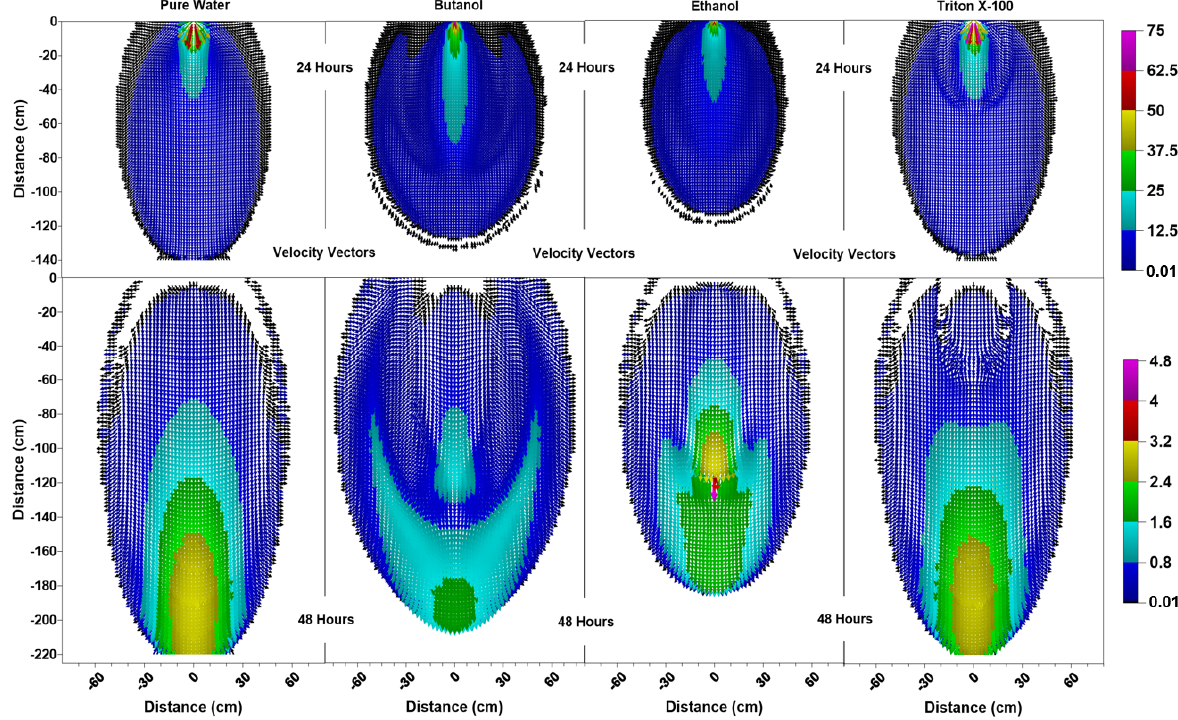
Figure 4. Velocity vector profiles (cm/day) at 24 h and 48 h for pure water butanol, ethanol and Triton X ‐ 100 solutions.